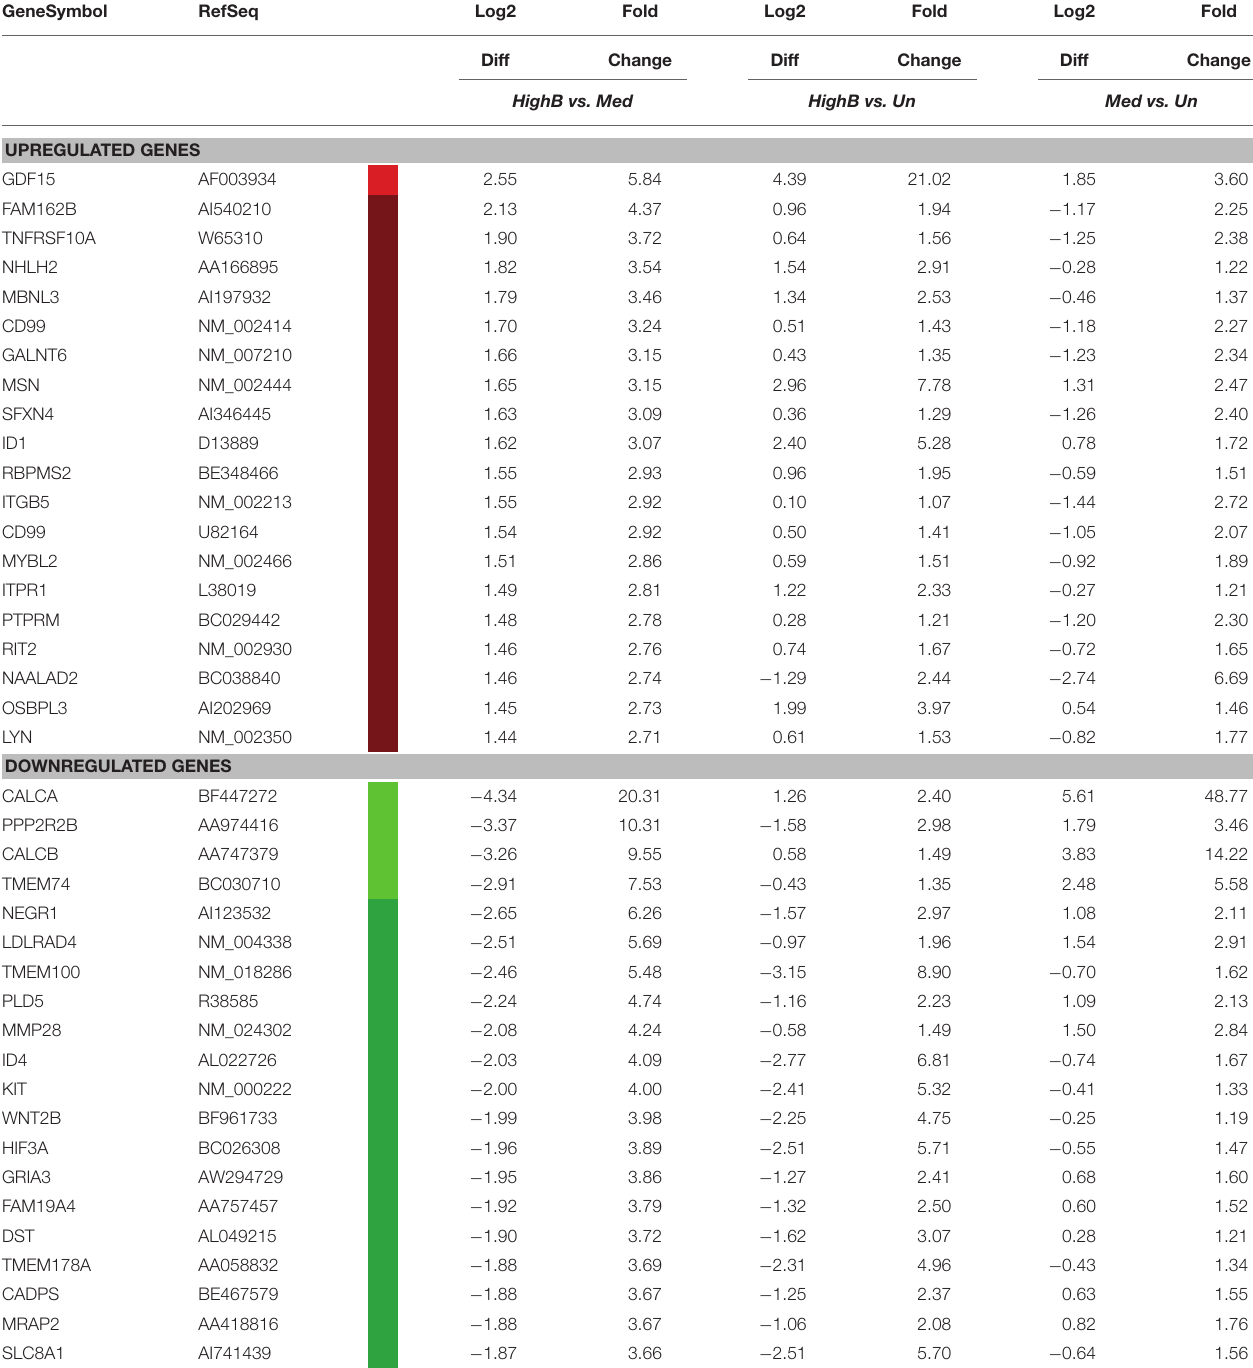
TABLE 6 | Differential Genes expressed by FtMT overexpressing SH-SY5Y neuronal cells. GeneSymbol